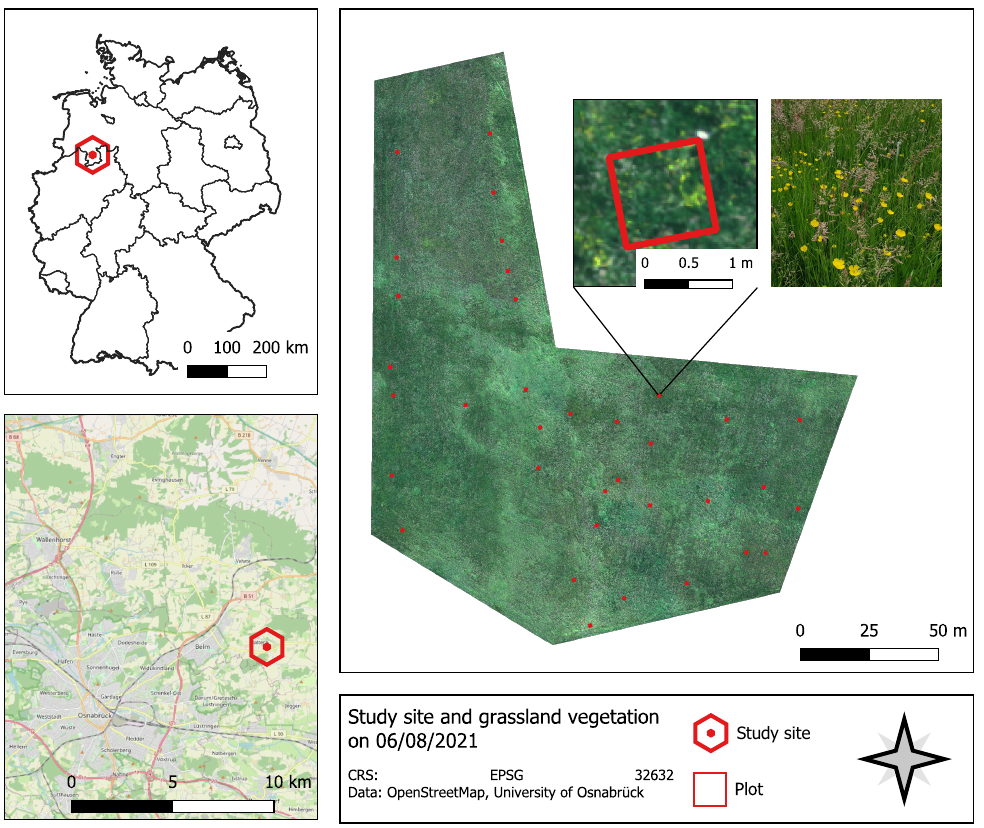
Figure 1. Location of the study site in Germany ( top left ) and the district of Osnabrück ( bottom left ). Orthomosaic and grassland vegetation of one plot of 06/08/2021 ( right